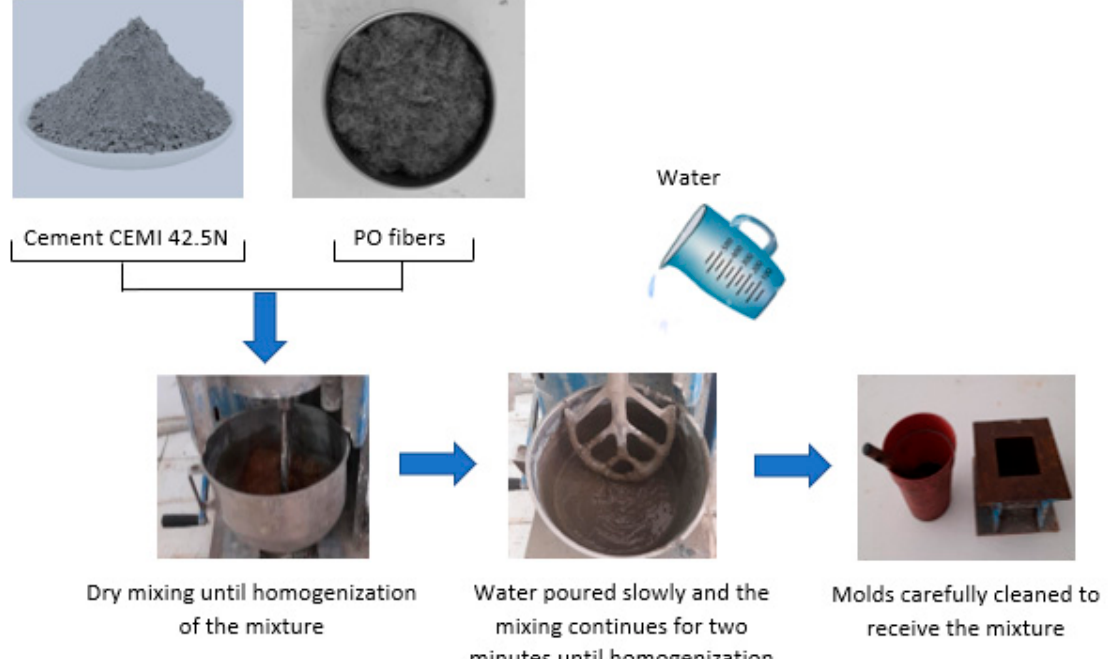
Figure 1. Flow chart of the preparation steps of the